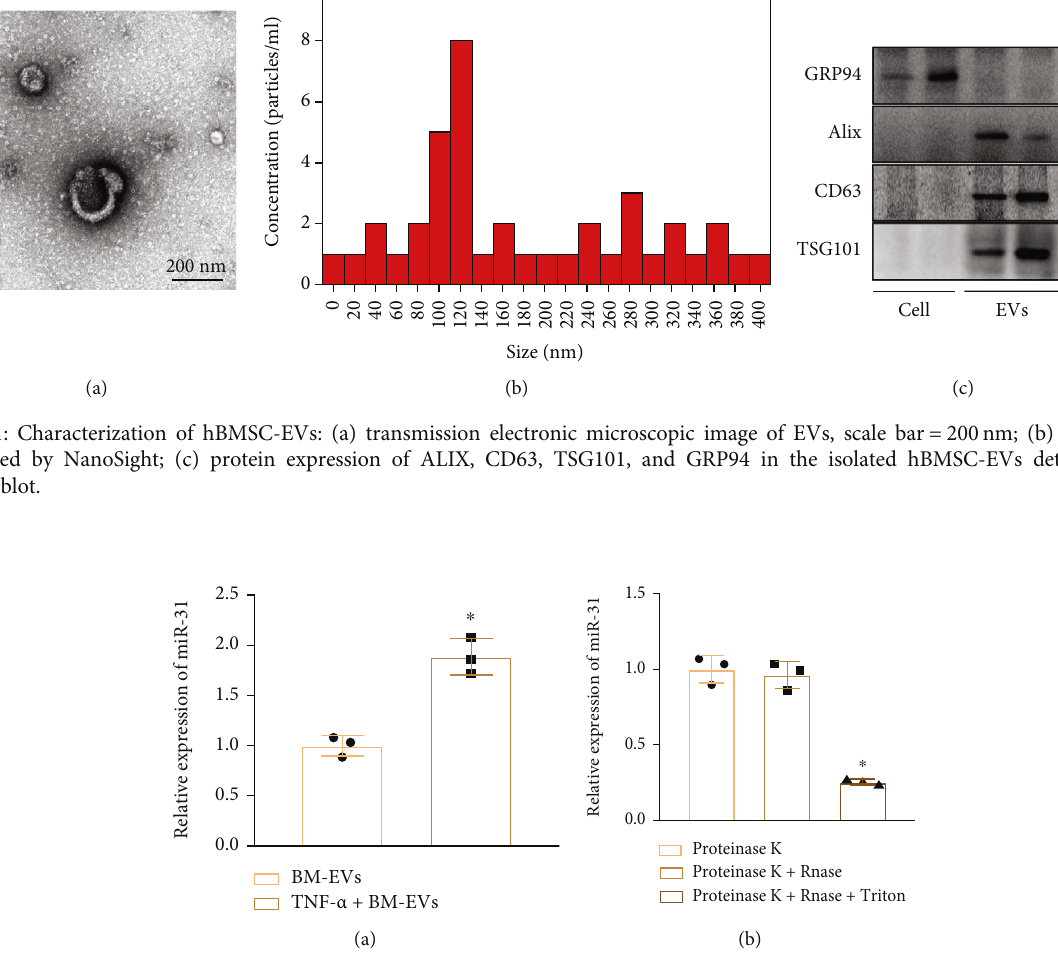
Figure 2: miR-31 expression in the isolated hBMSC-EVs: (a) miR-31 expression in the isolated hBMSC-EVs after TNF- α treatment determined by RT-qPCR; (b) miR-31 expression in the isolated hBMSC-EVs after RNAse or proteinase K treatment determined by RT- qPCR. ∗ p < 0 : 05 vs. hBMSC-EVs or proteinase K+RNAse. Cell experiments were repeated three